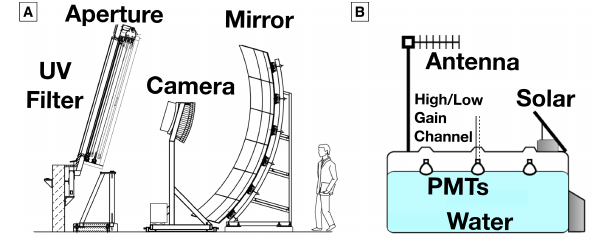
Figure 1. Panel A: one Schmidt telescope of the Auger FD. The light enters on the left through an aperture with a 2.2 m diameter. The aperture window has a UV filter to select the UV photons of the nitrogen fluorescence. The mirror has a 3.6 m diameter. The camera has 440 pixels, each with a 100 ns time resolution. Panel B: An SD station of area 10 m 2 and depth 1200 mm, filled with purified water, has three PMTs with a 25 ns resolution. Ultra- relativistic charged particles traveling through the detector create Cherenkov light recorded by the